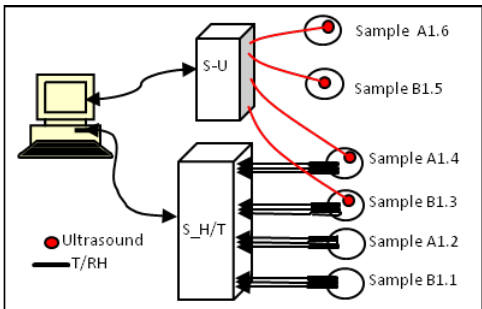
Figure 6. Multi-sensorial system for